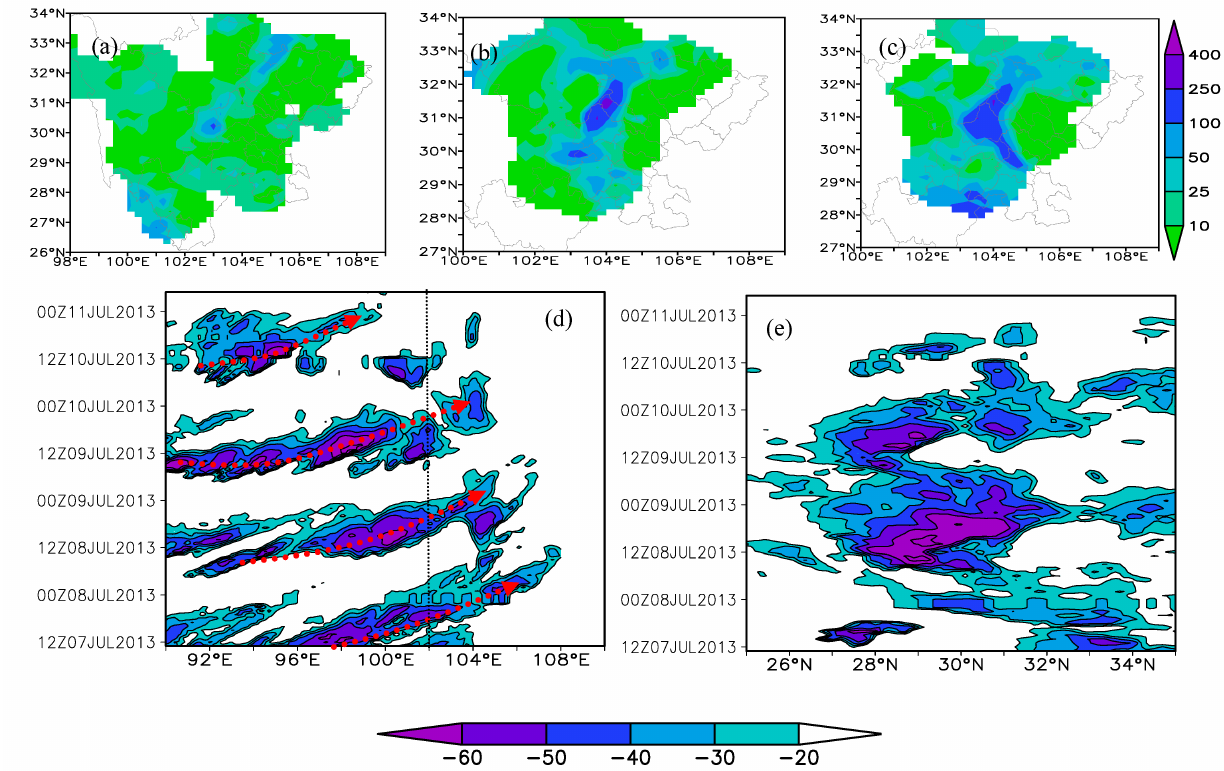
Figure 2. The cumulative precipitation of the first period ( a ) (1200 UTC 7 July to 0600 UTC 8 July), second period ( b ) (0700 UTC 8 July to 0600 UTC 9 July), and third period ( c ) (0700 UTC 9 July to 0000 UTC 11 July) (unit: mm), and cross- sections of hourly Tb (unit: ◦ C) along the average of 31.5–32 ◦ N ( d ) and 103–103.8 ◦ E ( e ) (1200 UTC 7 July to 0000 UTC 11 July). In Figure 2d, the red arrow is the evolution direction of the convective cloud belt; the black dotted line is the boundary between the plateau and the